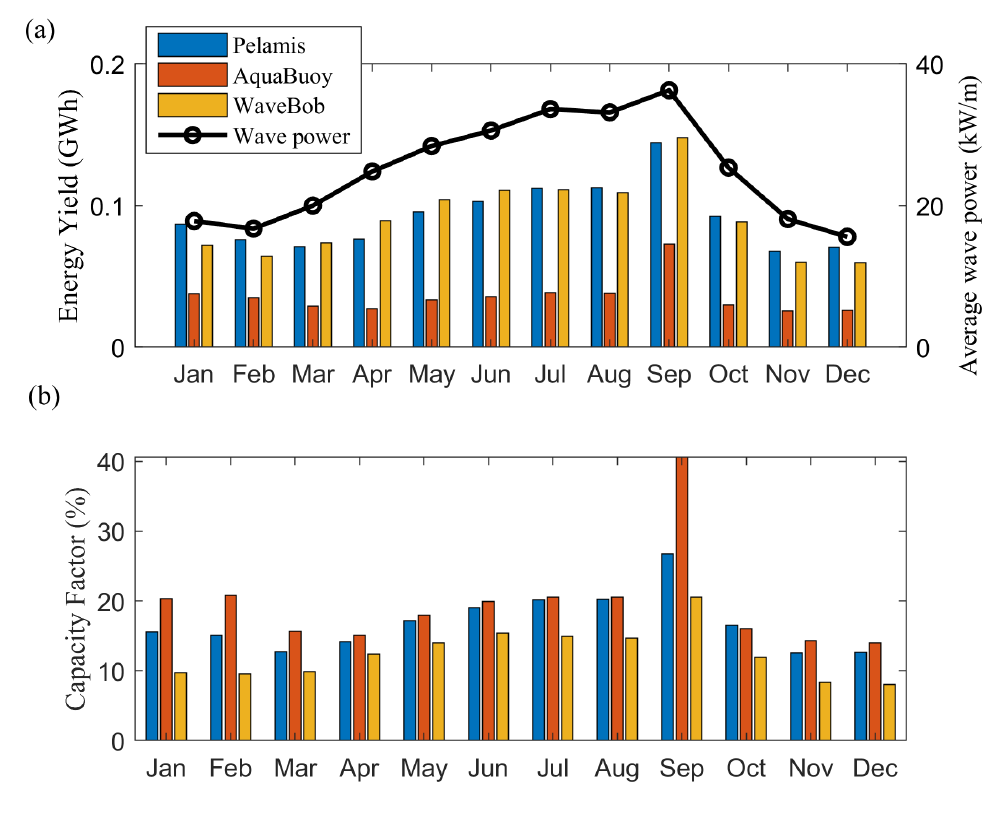
Figure 15. The performance of the three WEC devices at the second site off the coast of Penyu Bay; ( a ) the average monthly energy yield in GWh and ( b ) the WEC capacity